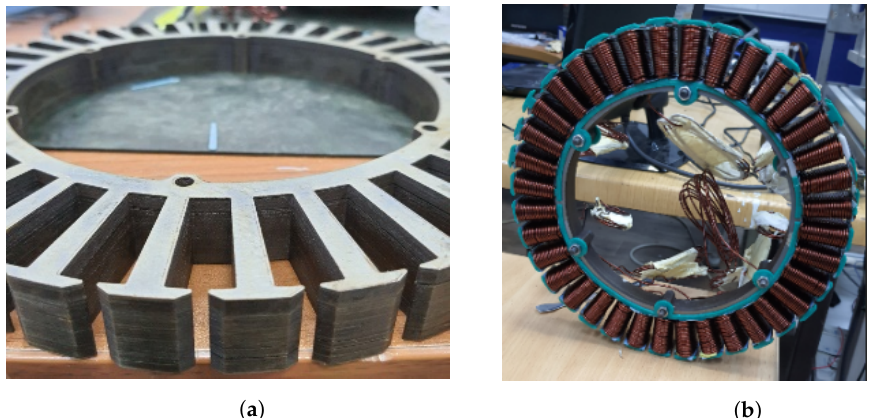
Figure 20. Stator structure of the motor: ( a ) stacking of the stator sheets cut using the wire-erosion cutting technique and ( b ) stator slots with winding.